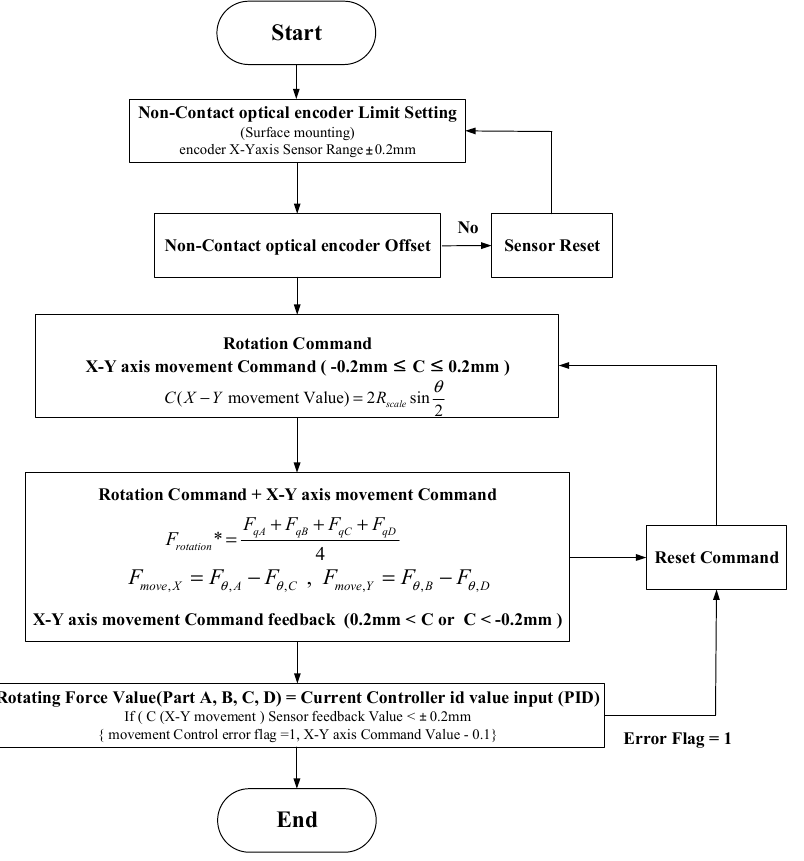
Figure 12. Control command calculation process for X–Y axis movement (* is command value).